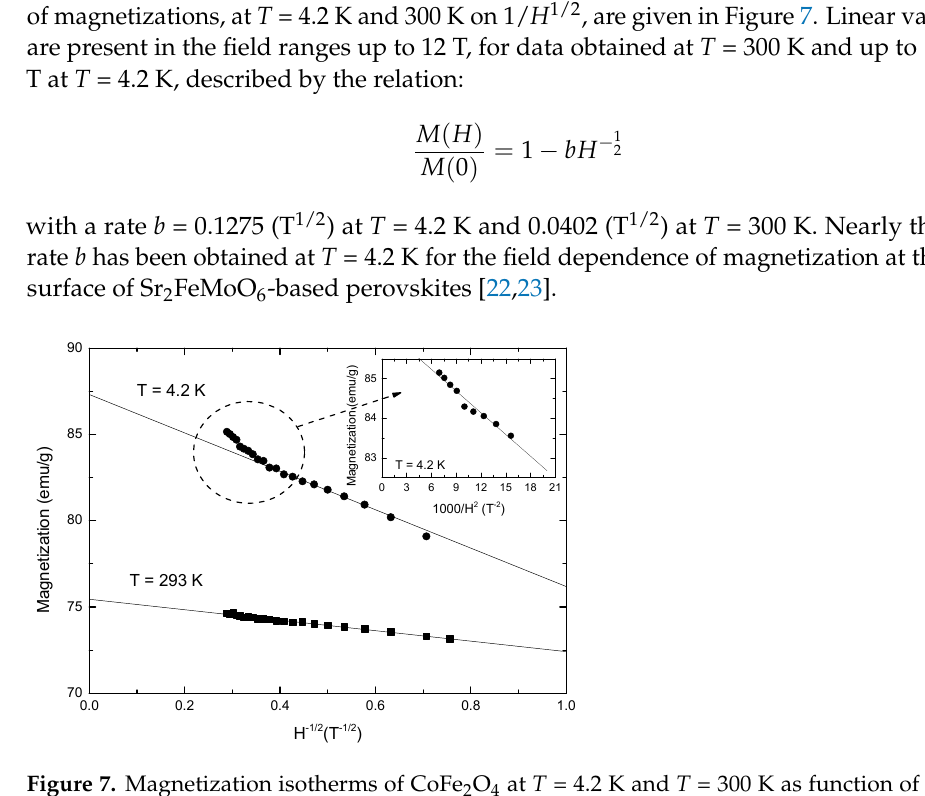
Figure 7. Magnetization isotherms of CoFe 2 O 4 at T = 4.2 K and T = 300 K as function of H 1/2 . In inset, the data at T = 4.2 K for H > 8 T as a function of H − 2 .